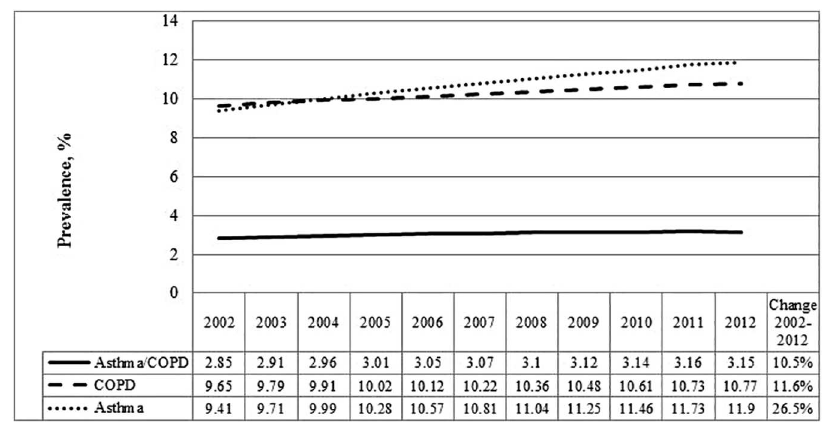
Fig 1. Age and sex standardized prevalencerates (%) for COPD, asthma and concurrent physician- diagnosed asthma and COPD over time among adults 35 yearsand older in Ontario, Canada.